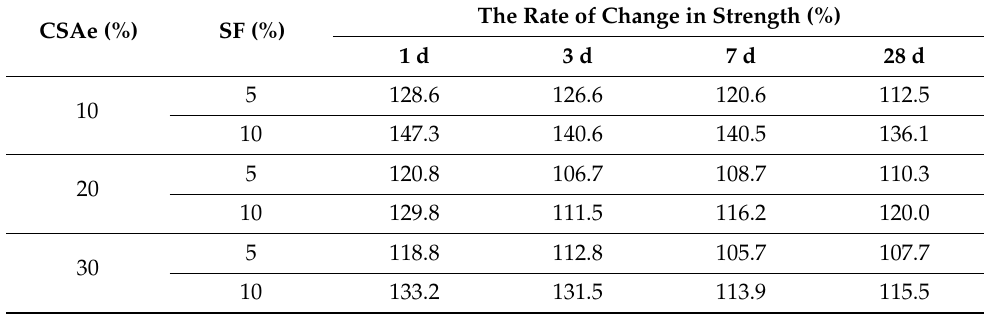
Table 3. The rate of change in strength of with SF to without SF samples by measurement age The Rate of Change in Strength CSAe (%) SF (%)